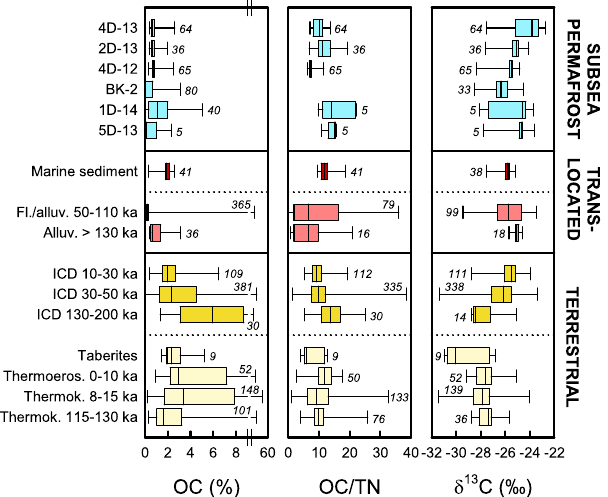
Fig. 5 | Lignin source proxies in subsea permafrost. Subsea permafrost data represent the thaw fronts of cores 4D-13, 2D-13, and 4D-12 from the Buor- Khaya Bay. S/V syringyl/vanillyl, C/V cinnamyl/vanillyl. Gray areas indicate ranges of different plant tissue types 14,63,71 – 74 . Data from previous studies in northeast Siberia are shown for comparison (means±standard deviation), including Buor- Khaya Bay surface sediments (mar. sed.) 14,42,48 , Lena River suspended matter, Ice Complex deposits (ICD) 14,48 , Holocene peat permafrost (pf.) 14 , and active layer (AL) material from tundra and boreal forest (taiga) locations 48